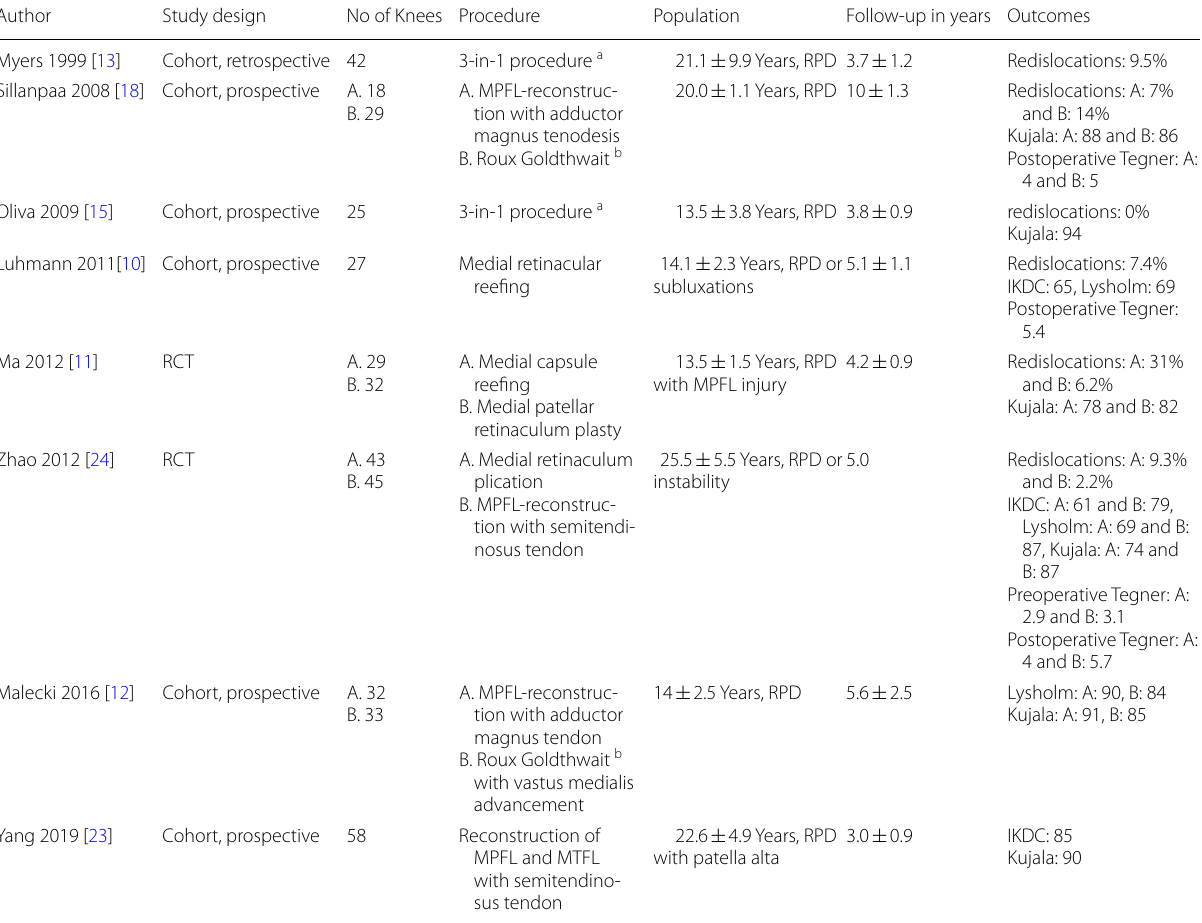
Table 5 Characteristics and outcomes of comparable